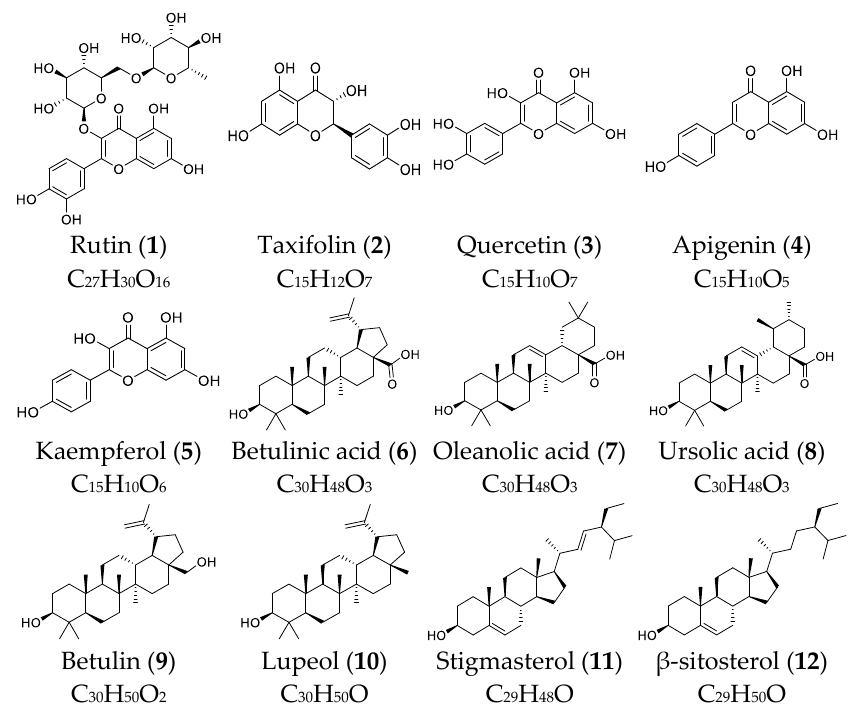
Figure 1. Secondary metabolites of plant origin used in the current study.